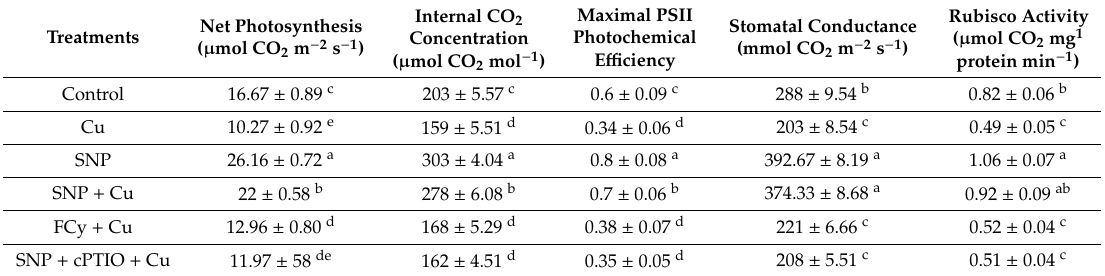
Table 2. Net photosynthesis, intercellular CO 2 concentration, Maximal PSII photochemical efficiency, stomatal conductance, and Rubisco activity in Indian mustard ( Brassica juncea L.) at 30 DAG. Seeds were treated at pre-germination time with water, 100 µM SNP or SNP with cPTIO and FCy in presence or absence of 3.0 mM Cu.